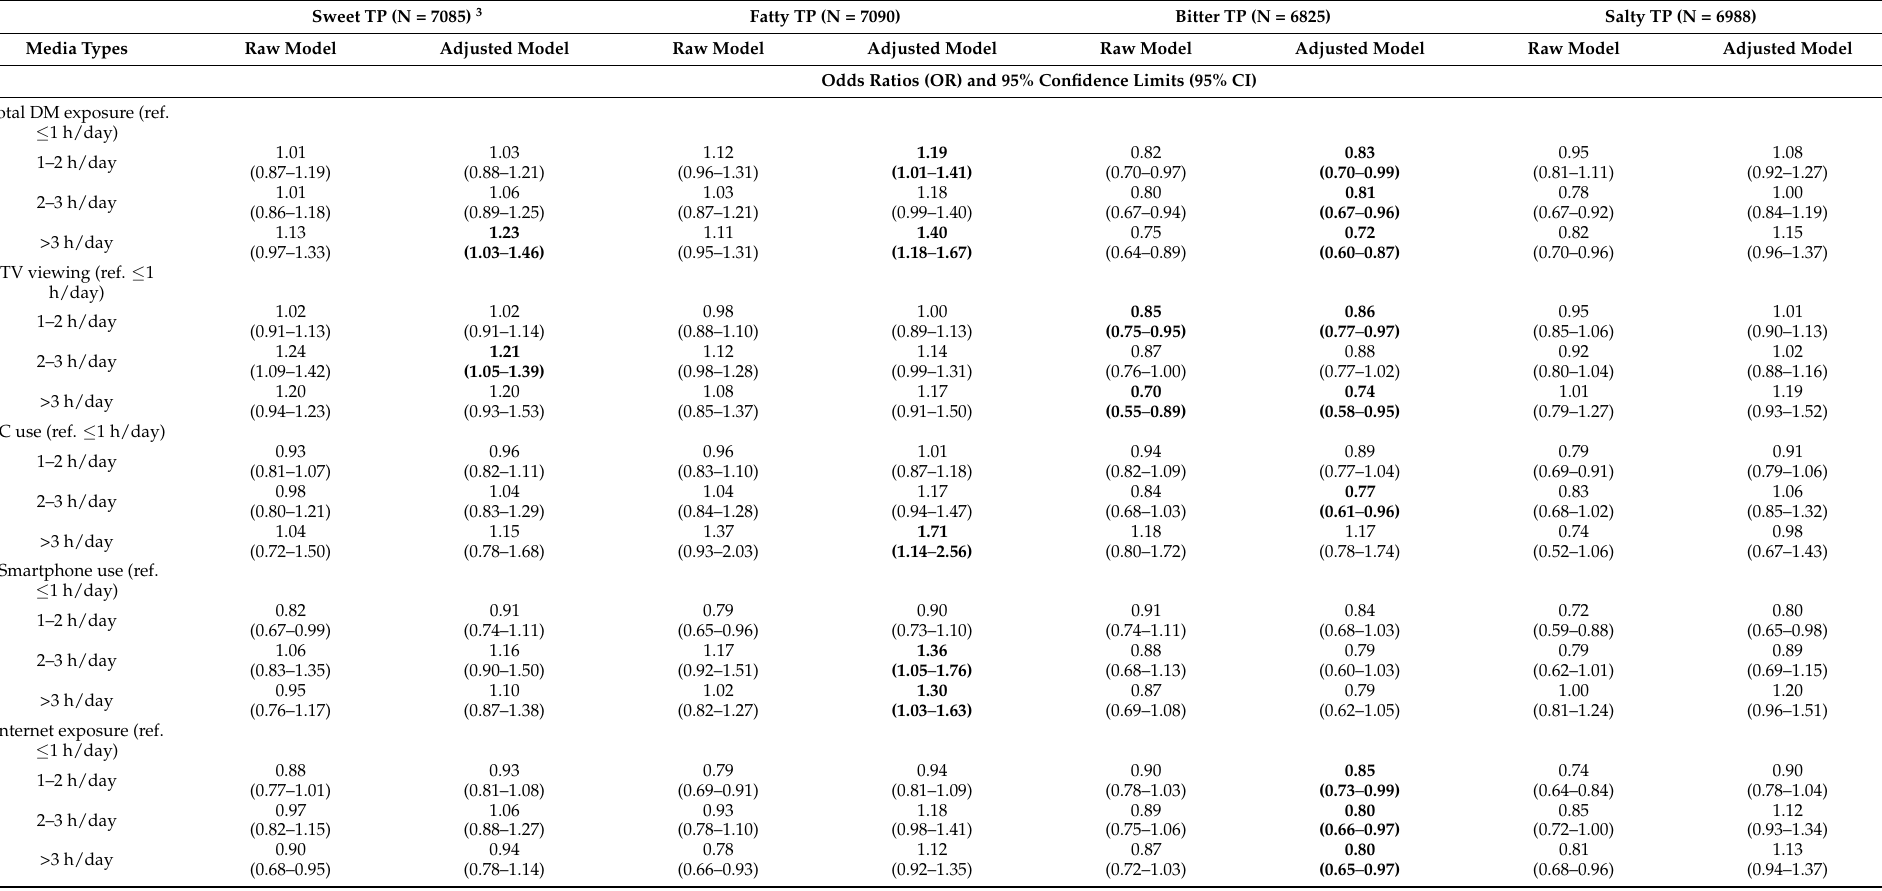
Table 3. Exposure to digital media in association with taste preferences in European children and adolescents 1,2